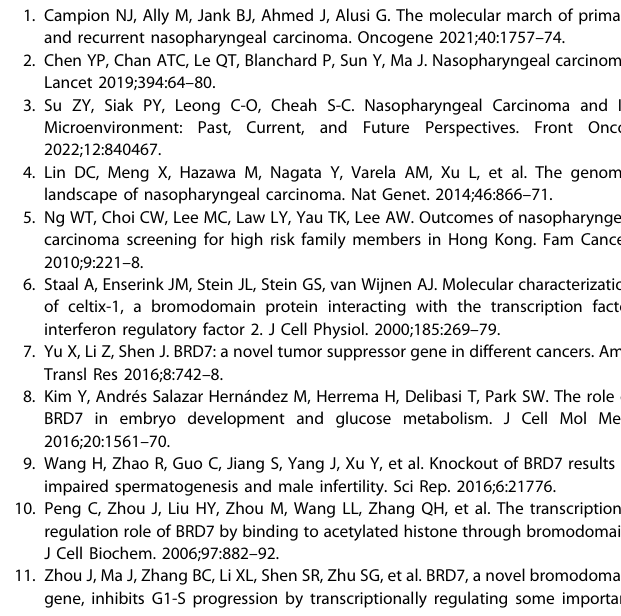
then incubated with species-matched secondary antibodies for 60 min at 37 °C. Bands were visualized by Western Blotting Substrate (Share-Bio, Shanghai, China), and signals were detected by an enhanced chemilumi- nescence detection system according to the manufacturer ’ s protocol (MiniChemi ™ I, SAGECREATION, China).